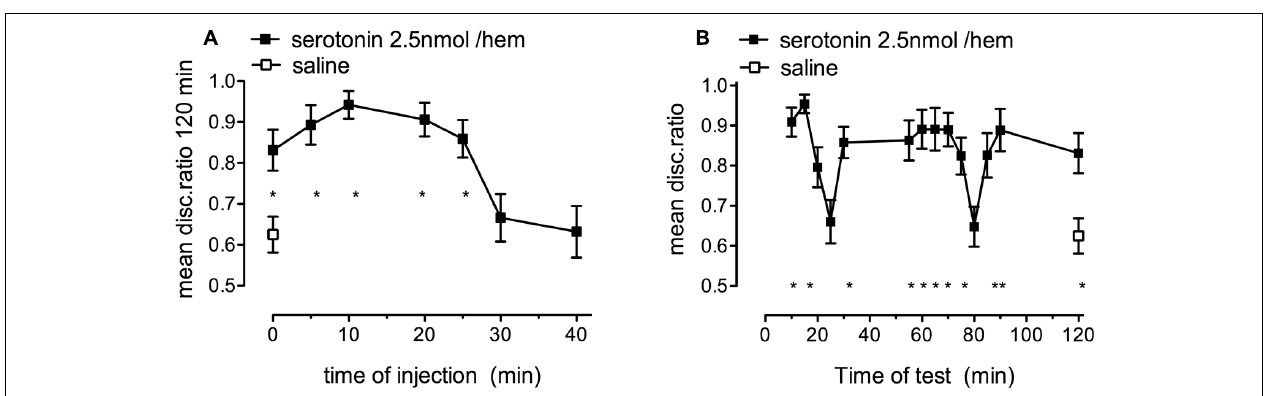
(B) After strongly reinforced training on 100% anthranilate, doses of 5.0 and 10 nmol resulted in memory loss, n = 14–20 per group, * P < 0.05 compared to saline.